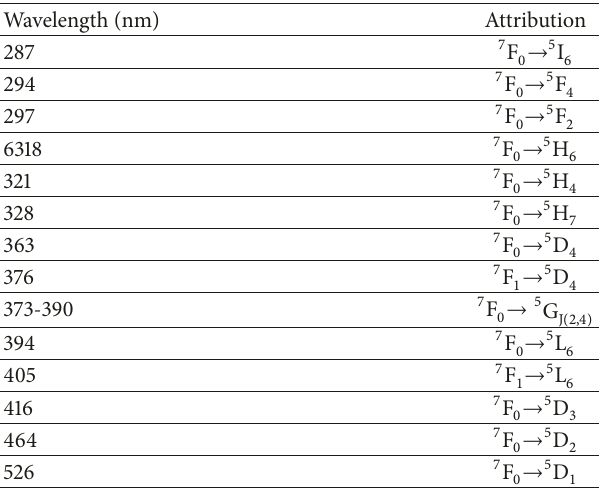
Table 6: Excitation lines attribution of Eu 3+ doped LiGd(PO 3 ) 4 . Wavelength (nm)